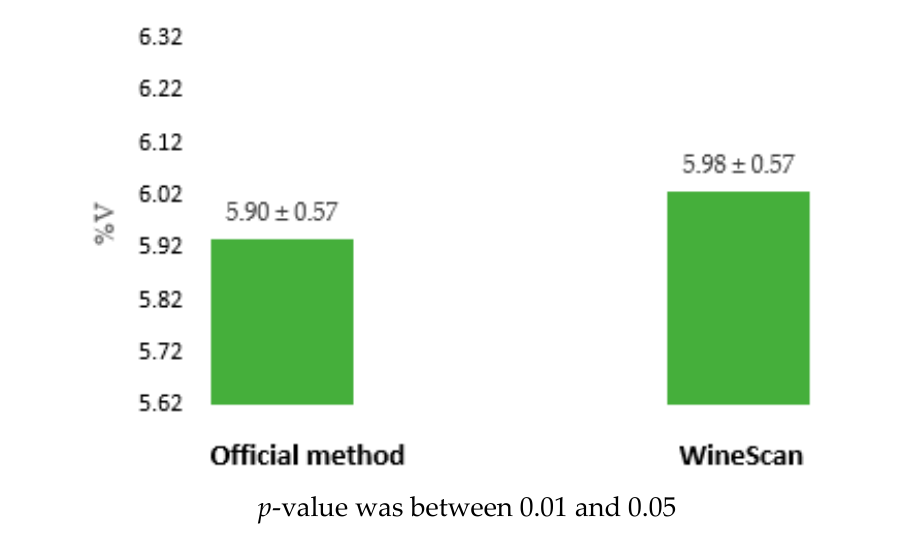
Figure 10. Average of total acid concentrations in wine samples determined by official method and WineScan technology.